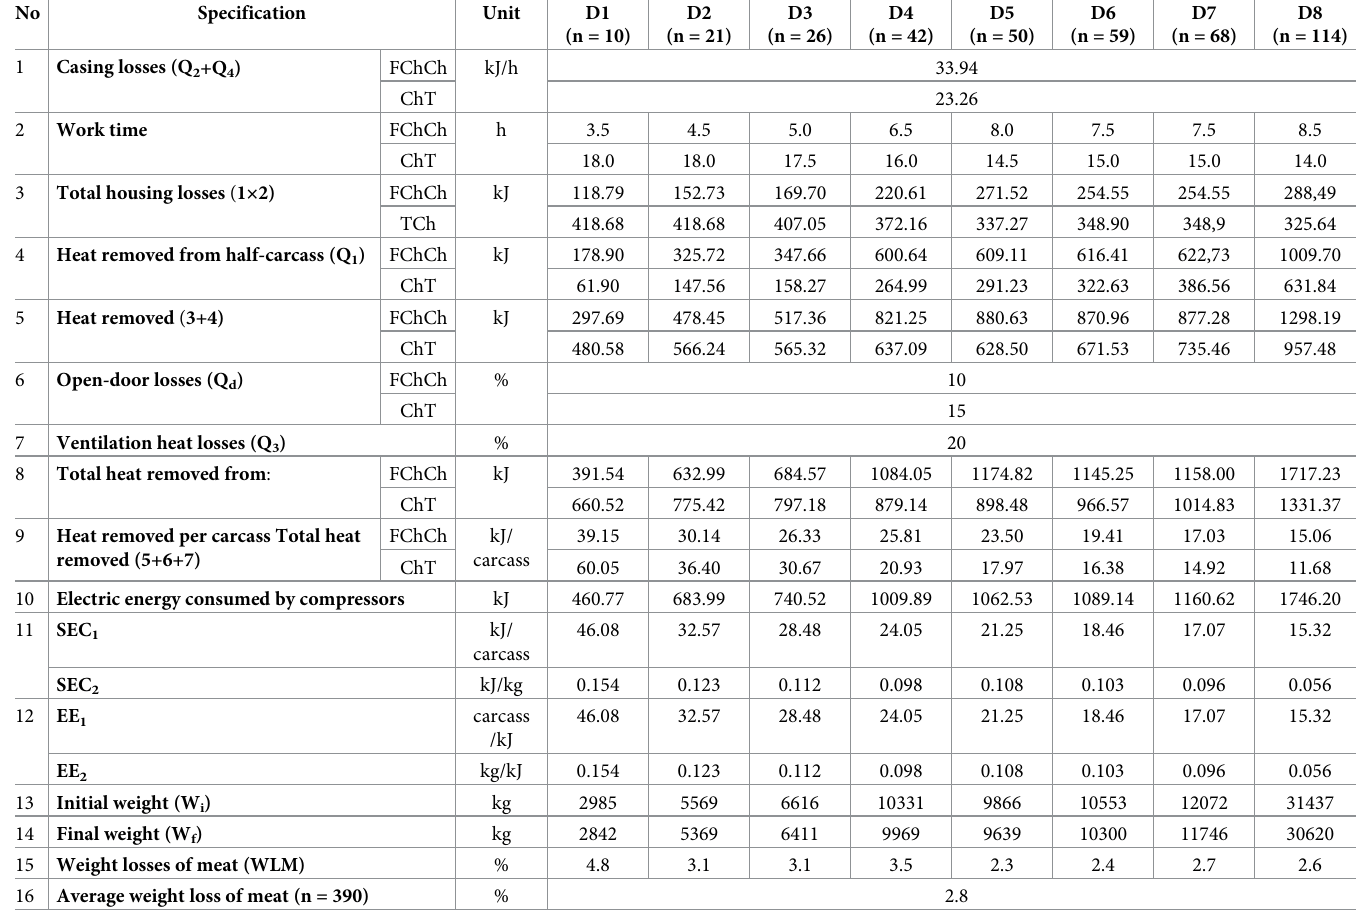
Table 5. Energy balance, Specific Energy Consumption (SEC), and Energy Efficiency (EE) for the fast chilling process, and changes in weight losses of electrostimu- lated meat during 8 days